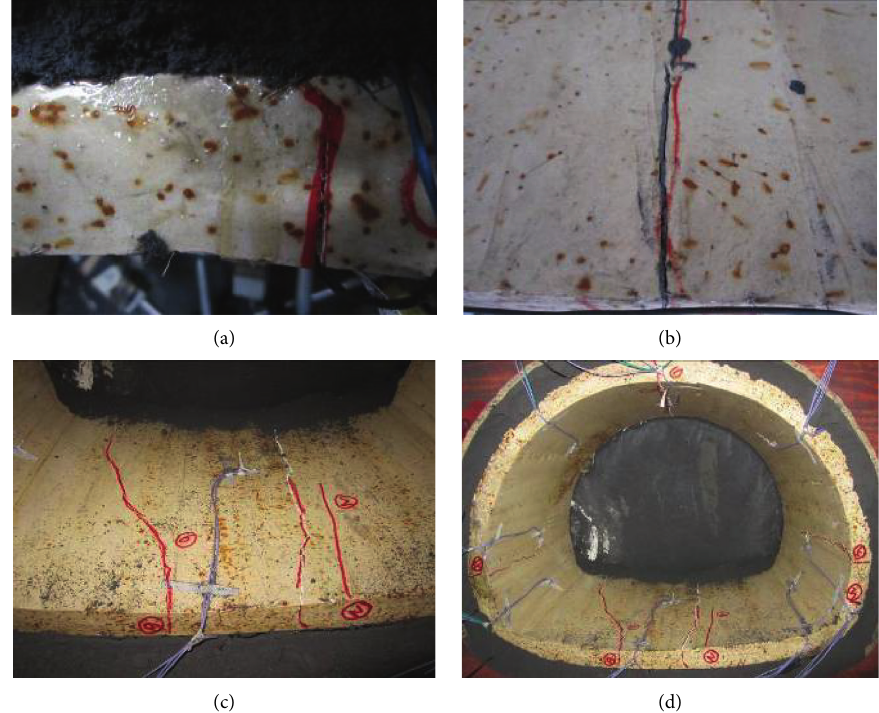
Figure 12: Lining cracks of the steel fiber reinforced concrete. (a) The first crack (vault). (b) The second crack (inverted arch). (c) Local multipoint cracking (inverted arch). (d) Final failure state of the structure.